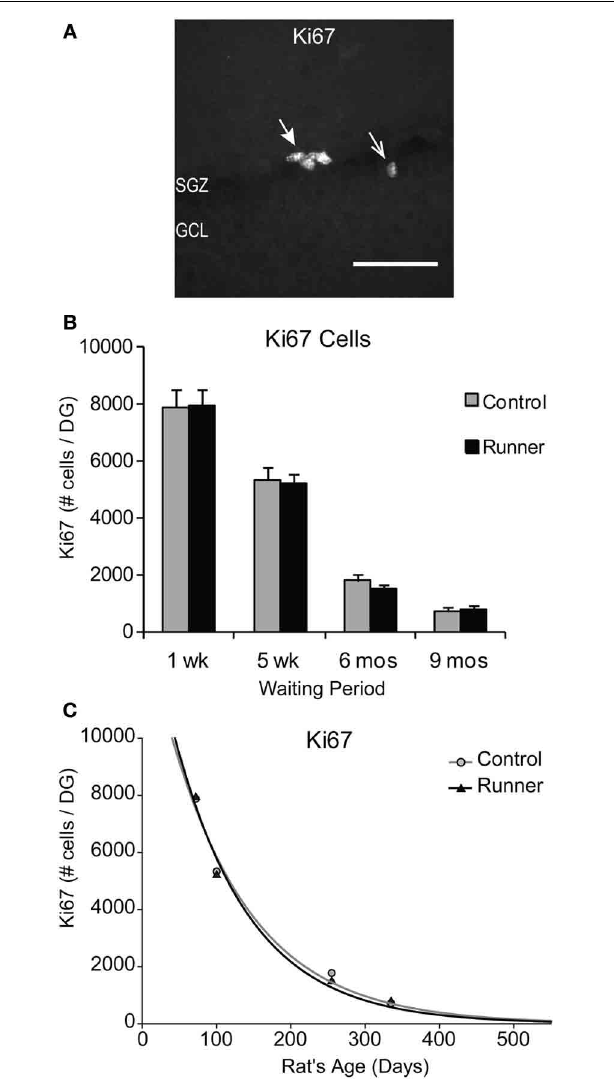
FIGURE 2 | Ki67 cells in the rat DG. (A) Image shows typical Ki67 labeling of proliferating precursors in the subgranular zone (SGZ) bordering between Hilus and granule cell layer (GCL). Full arrowhead indicates one cluster of several nuclei and open arrowhead indicates one single nucleus. Scale bar, 50 μ m. (B) Numbers (mean ± s.e.m.) of Ki67 cells per DG. No significant differences were found between Runners and Controls in any cohort (Two-Way ANOVA, P = 0 . 969). (C) Exponential decay curve fitted to the data for controls (circles) and runners (triangles) show the decay of proliferation with age. In this and subsequent figures the curves were fitted using regression procedure and were significant at P < 0 . 05. The two parameters were a = 14 . 376 and b = 0 . 0090 in Controls and a = 15 . 418 and b = 0 . 0098 in Runners. Thus, there were no significant differences between the initial cell numbers (a) or rate constants